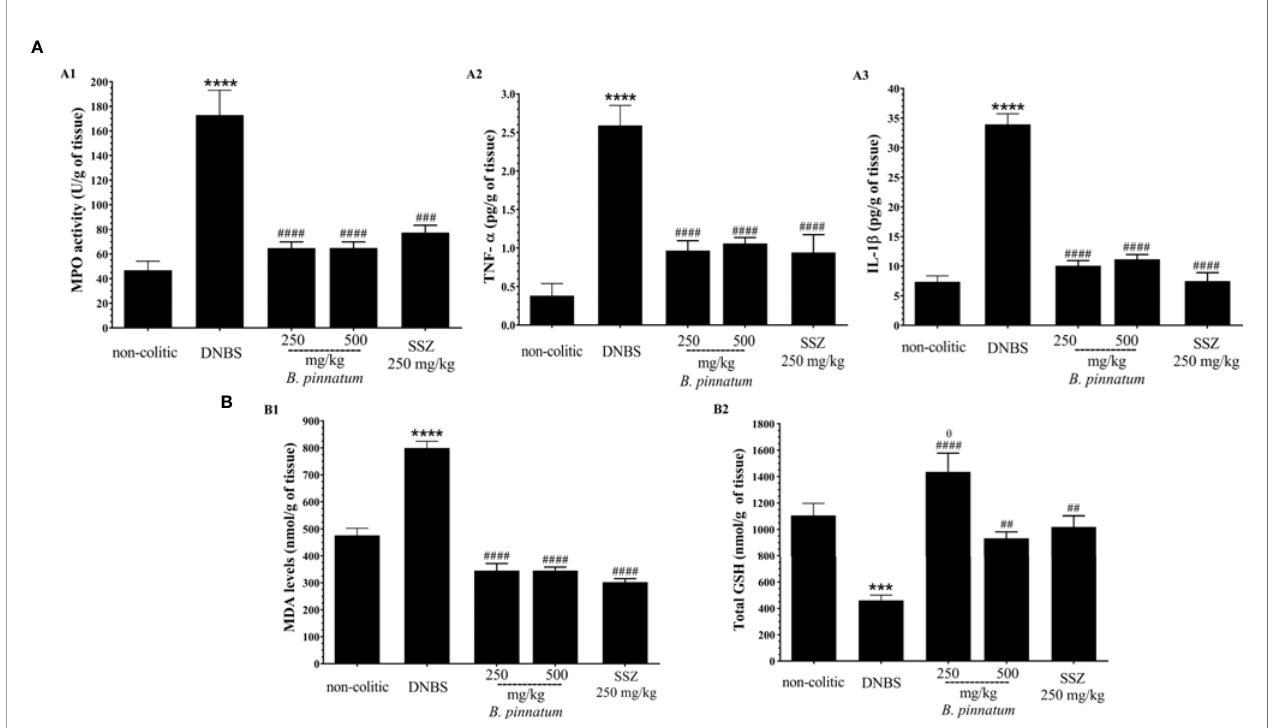
FIGURE 3 | Effect of hydroethanolic extract from B. pinnatum leaf (HEBP) on in fl ammation markers (A) : myeloperoxidase activity (MPO) (A1) , TNF- a (A2) , and IL-1 b (A3) and oxidative markers (B) : malonaldialdehyde content (MDA) (B1) and GSH (B2) in the intestinal in fl ammation of the experimental 2.4-dinitrobenzene sulfonic acid (DNBS) model. Data (n = 8) are presented as mean ± standard error from the mean. *** p < 0.001, **** p < 0.0001 compared with non-colitic group; # p < 0.05, ## p < 0.01, ### p < 0.001, #### p < 0.0001 compared with DNBS group; q p < 0.05, compared with SSZ 250 mg/kg